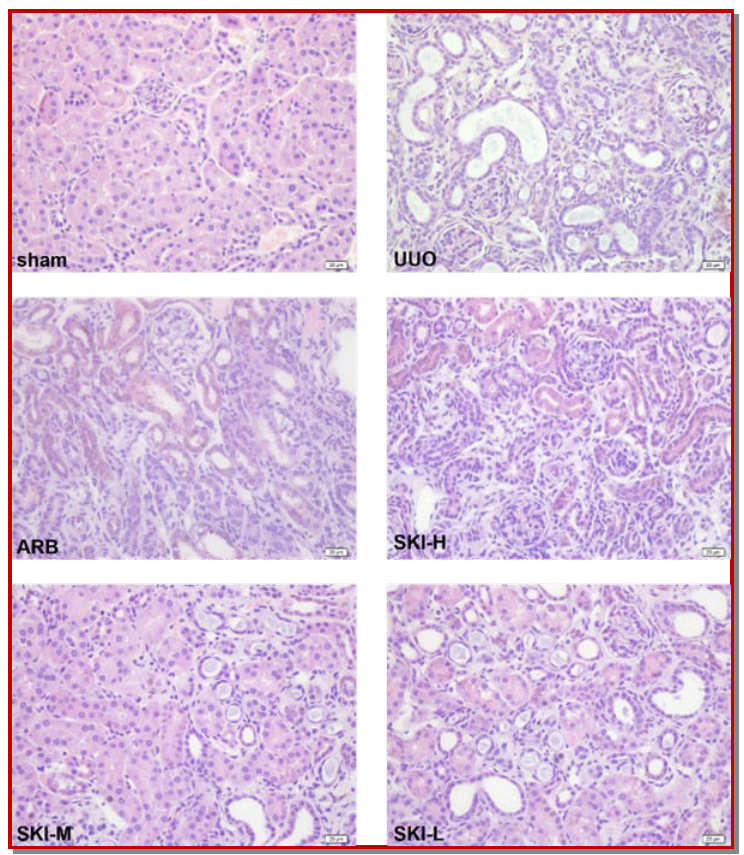
Figure 3: Effects of shenkang injection on renal pathology. Kidney biopsies were strained by hematoxylin and eosin to observe pathological changes (HE stains, 400×); SKI-H means shenkang injection (7.8 g/kg); SKI-M means shenkang injection (3.9 g/kg); SKI-L means shenkang injection (1.95